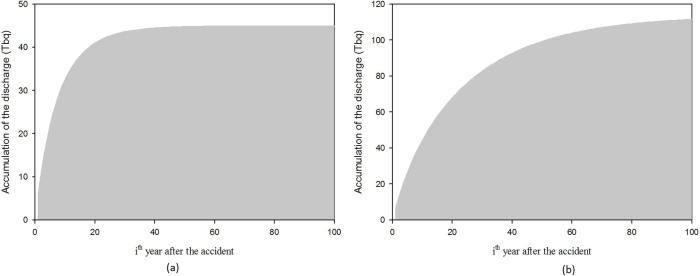
The accumulation of 134Cs (a) and 137Cs (b) flux into Pacific Ocean for 100 years after the accident.